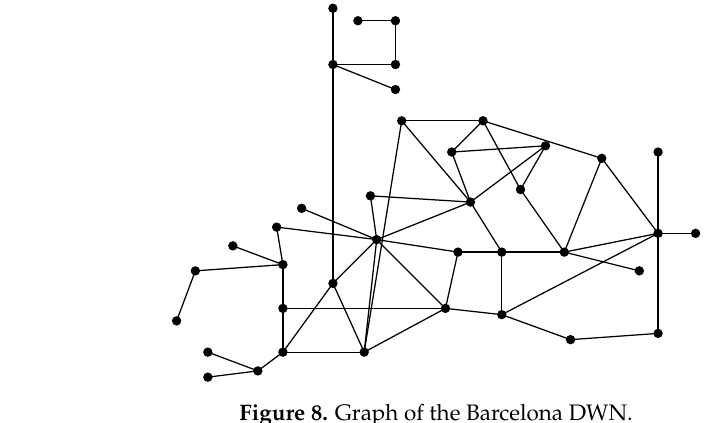
Figure 8. Graph of the Barcelona DWN.